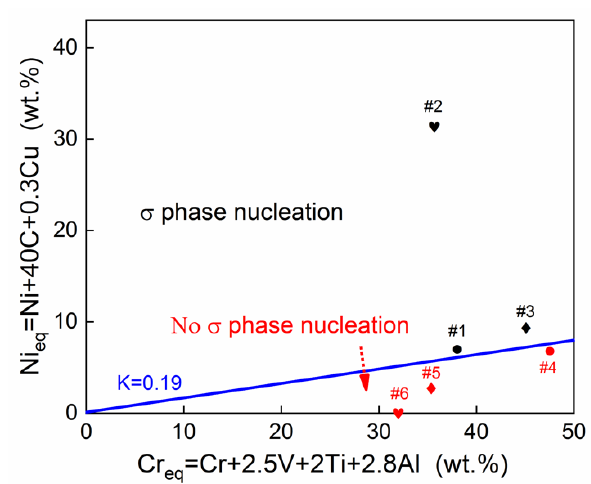
Figure 9. The different locations indicate the Cr/Ni ratio of the alloys.